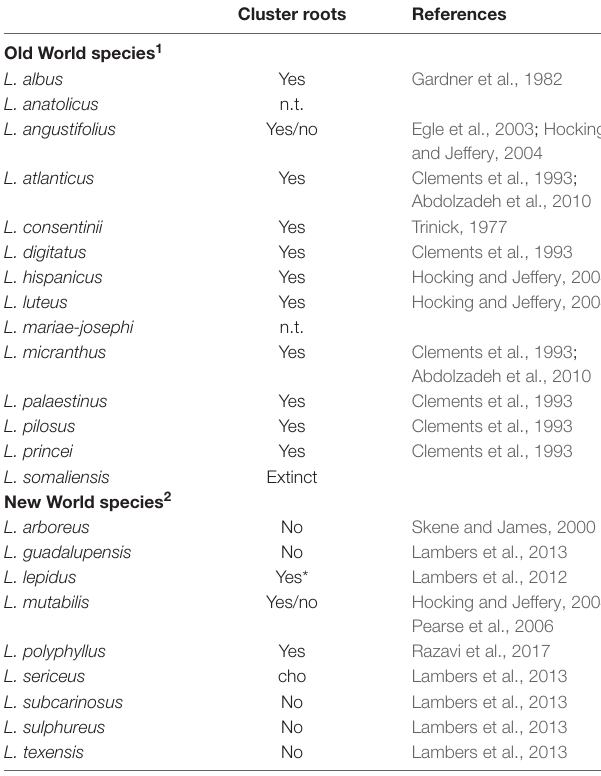
TABLE 1 | Lupinus species that have been tested for cluster roots formation. Cluster